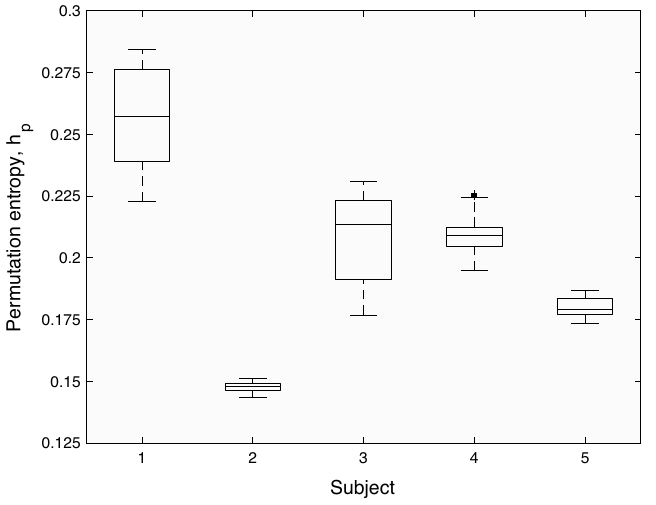
Figure 7. Distributions of permutation entropies obtained by sliding a window across the time series shown in Fig. 3 (see text for further details). In each box plot, the central line denotes the median and the bottom and top edges indicate the 25th and 75th percentiles, respectively. The whiskers show the most extreme data points that are not considered outliers, with outliers plotted as